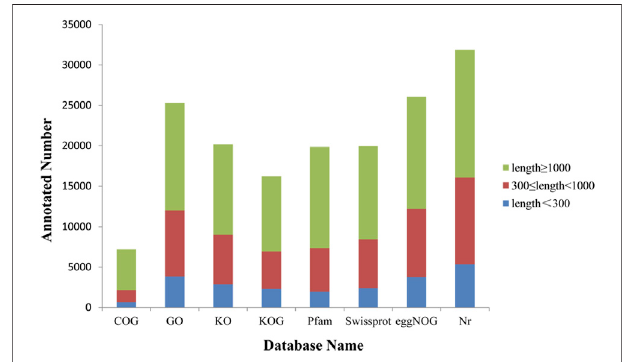
FIGURE 5 | Gene annotations in different databases. The X -axis is the database name. The Y -axis is the number of genes annotated. Unigenes